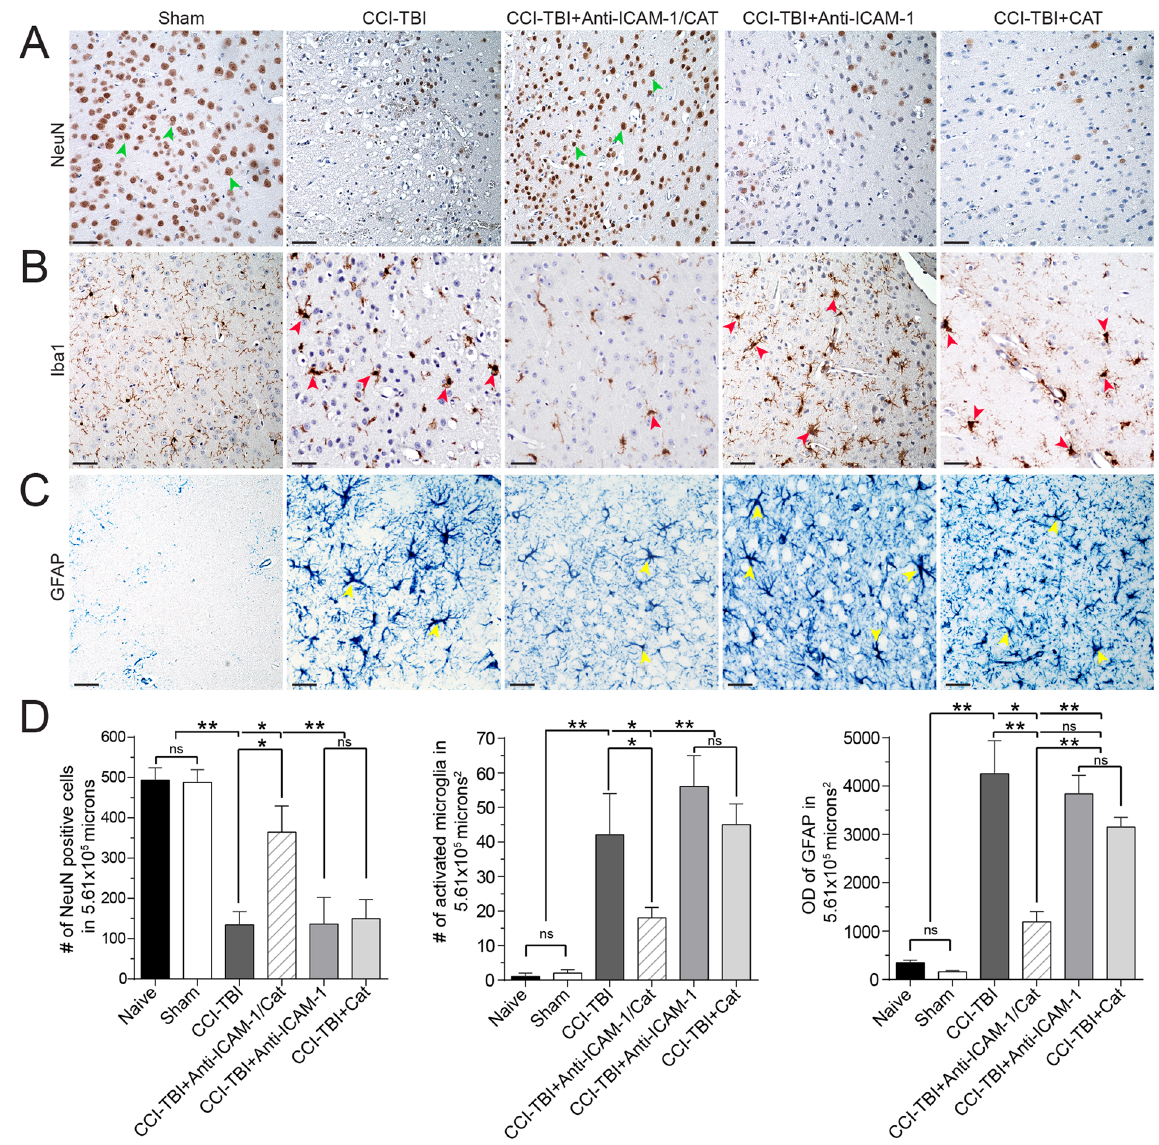
Figure 6. Diminished neuropathology indices with acute anti-ICAM-1/catalase administration following CCI- TBI demonstrated by immunohistochemical staining for neurons, astrocytes, and microglia. ( A ) NeuN staining identifies viable neurons within the cerebral cortex and demonstrates substantial neuronal loss 48 hrs following CCI-TBI. Primary injury mechanisms invariably result in cell death, as indicated by persistently decreased NeuN detection, based on particle count analysis, that is rescued with targeted antioxidant enzyme intervention. NeuN detection following anti-ICAM-1/catalase administration was significantly higher than CCI-TBI alone or in combination with recombinant catalase and anti-ICAM-1. Green arrows point to nuclear stain of NeuN. ( B ) Microglia are finely ramified with small cell bodies in the sham condition. Following CCI-TBI, number of activated microglia per 5.61 × 10 5 microns squared is significantly increased as indicated by threshold increases in cell body size and Iba1 staining intensity. Anti-ICAM-1/catalase reduced the number of amoeboid microglia per frame, while catalase and anti-ICAM-1 alone did not. Red arrows point to amoeboid microglia. ( C ) GFAP expression indicating astrocyte activation shows significant increase at 48 hrs following CCI-TBI compared to optical density readouts per 5.61 × 10 5 microns squared for the sham group. Anti-ICAM-1/catalase significantly reduced optical density of GFAP detection at 48 hrs after CCI-TBI compared to CCI-TBI alone. Non-targeted catalase and anti-ICAM-1 controls did not offer benefit regarding astrocyte activation following CCI-TBI, with no significant difference from CCI-TBI alone. Yellow arrows point to astrocytes with robust GFAP staining detection. Scale bars equal 50 microns. ( D ) Associated bar graphs display imaging quantification. Naive animals were included in image analysis and quantification but are not displayed in the montage. Data are presented as mean ± SD. (Ordinary one-way ANOVA. NeuN: F = 39.83, P < 0.0001. Iba1: F = 58.81, P < 0.0001. GFAP: F = 117.8, P <